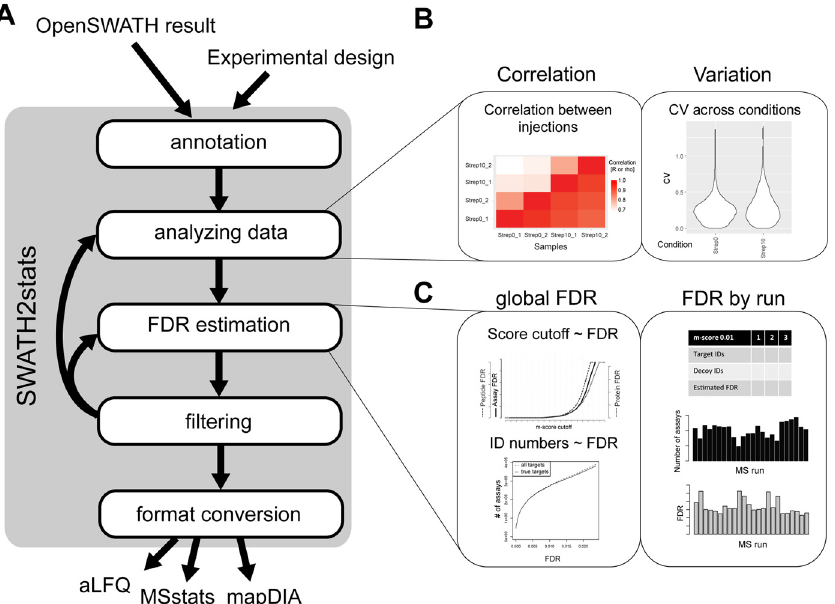
Fig 1. Overview of the R/Bioconductor package SWATH2stats. (A) SWATH2stats uses the OpenSWATH results or results from similar software. The information on the experimental design for annotation of the conditions and replicates can be provided separately or extracted from the OpenSWATH data. The data is processed along 5 different steps (annotation, analyzing the data, false discovery rate (FDR) estimation, filtering, format conversion) using different functions (Table 1) until the data can be directly exported in a suitable format for the downstream analysis tools aLFQ, MSstats, and mapDIA. (B) Shown are example plots from the package that show the correlation of signals between injections or the coefficient of variation (cv) across conditions. (C) Shown are example plots on how the estimated global FDR or FDR by run changes depending on different score